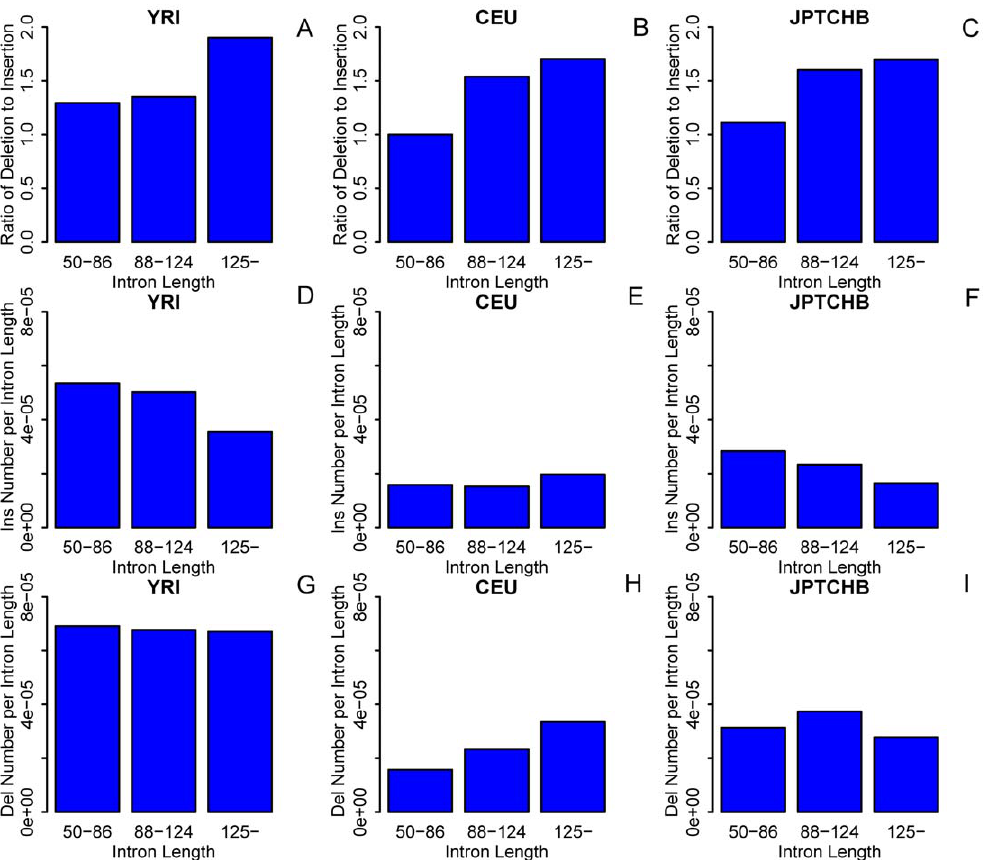
Figure 2. Indel counts and ratios. RDI (A, B, C), insertions (D, E, F) and deletions per intron length (G, H, I) in different minimal intron size intervals of the three populations (DAF , 0.1).